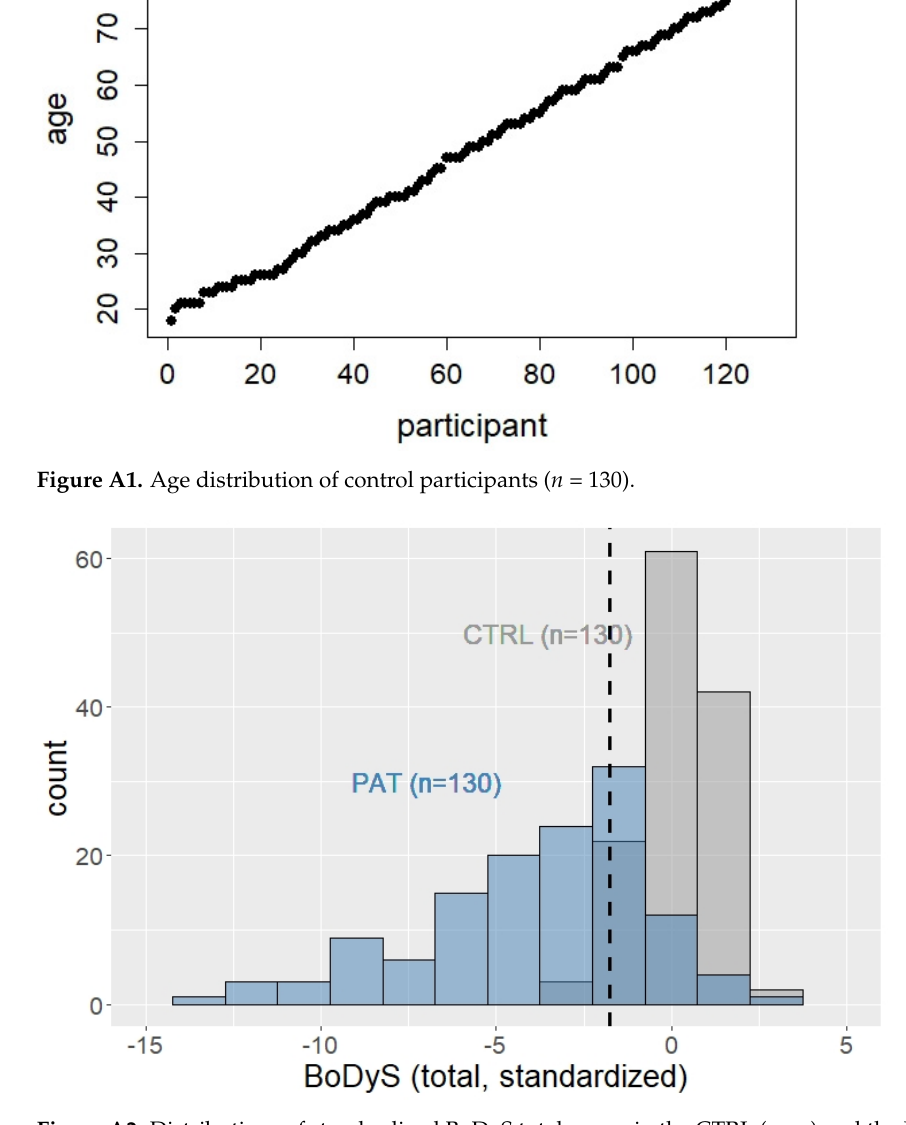
Table A8. Between-factor correlations for the five CFA factors corresponding with the EGA dimen- sions plotted in Figure 2.